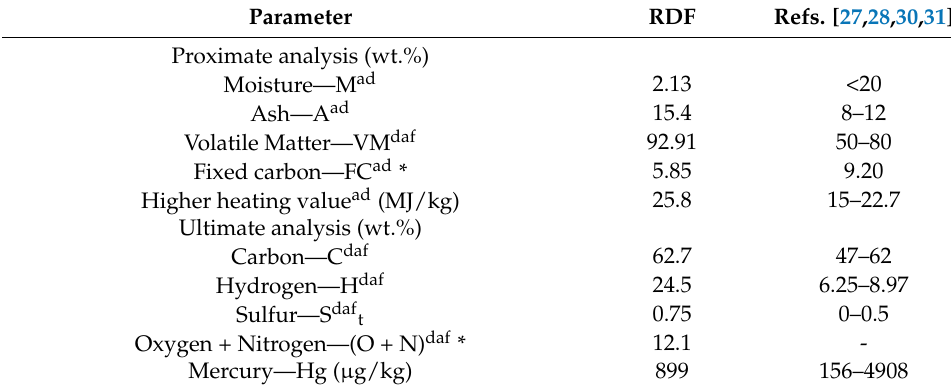
Table 1. Characteristic of